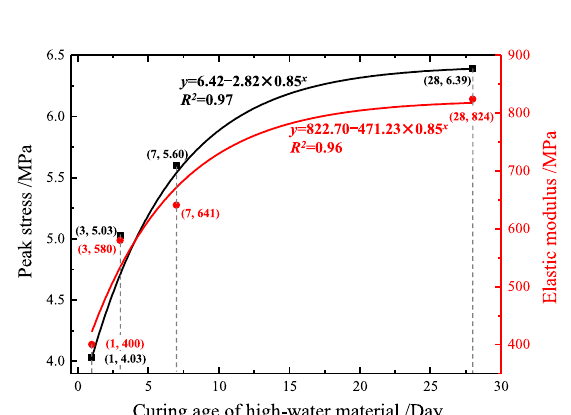
Fig. 8 Curves of peak compressive strength, elastic modulus, and curing age of high-water